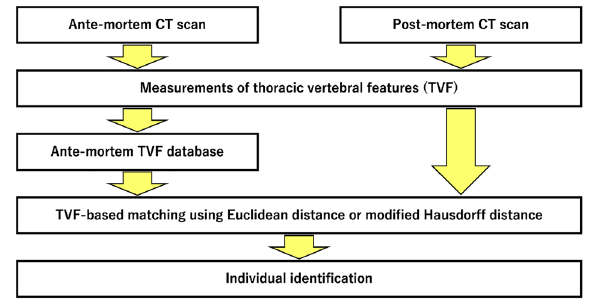
Figure 4. Flowchart of the study